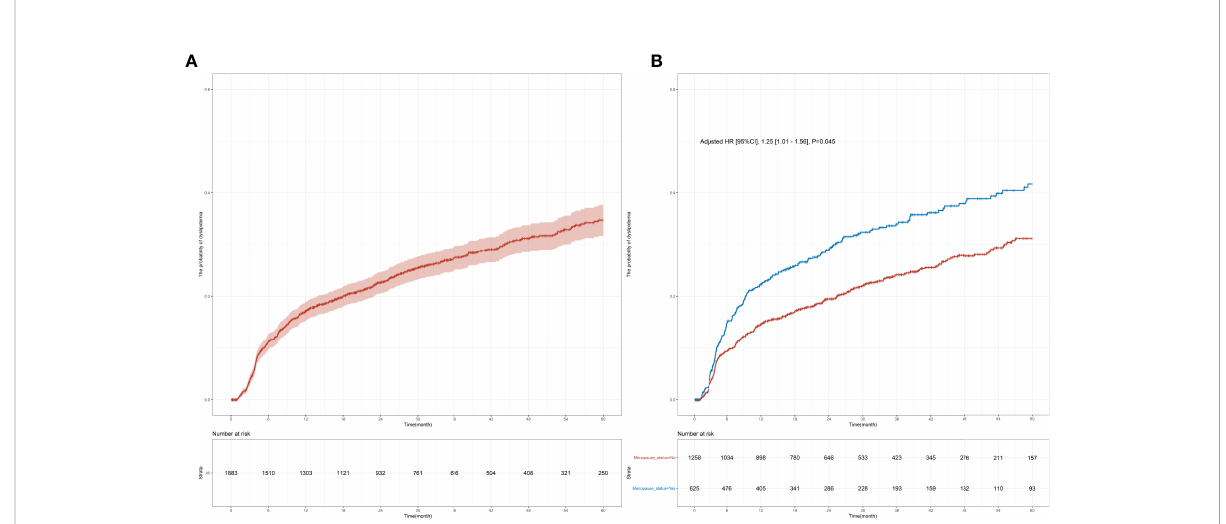
FIGURE 2 Cumulative dyslipidemia incidence among premenopausal and menopausal early-stage breast cancer patients (EBC). Cumulative curves (A) showing dyslipidemia incidence in all EBC patients receiving endocrine therapy and (B) showing dyslipidemia incidence among different menopausal